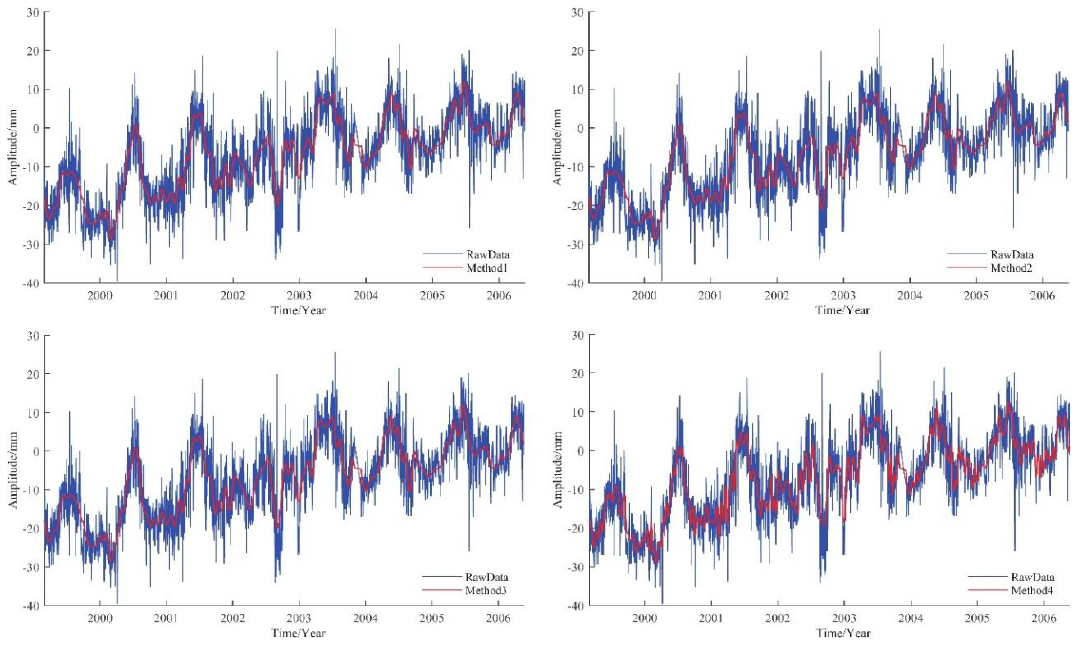
Figure 17. BJFS station U direction time series processed by four noise reduction methods.